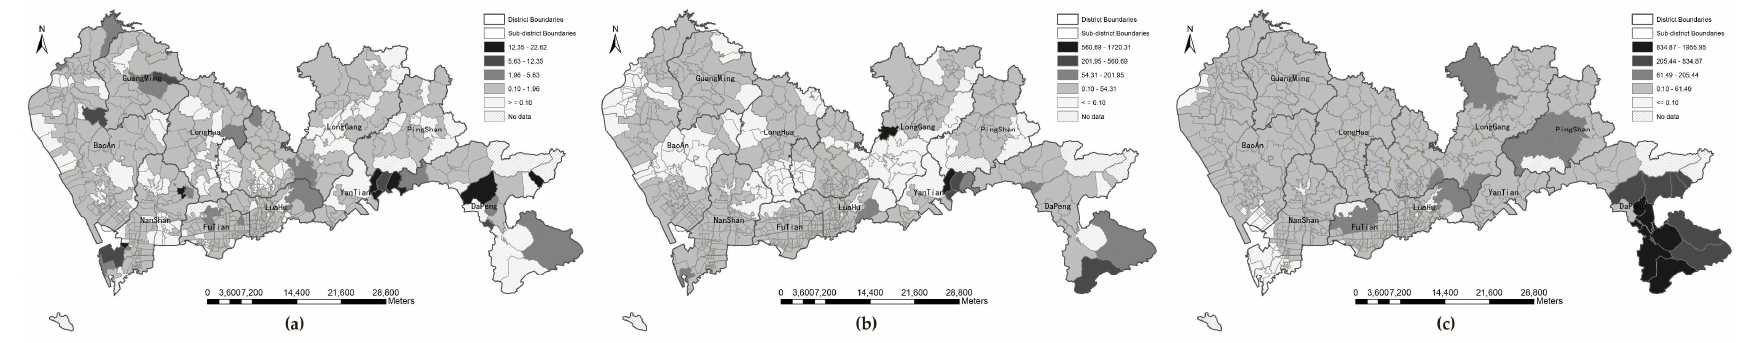
Figure 7. Park accessibility by walking distance at three park levels: ( a ) community park level; ( b ) city park level; ( c ) natural park